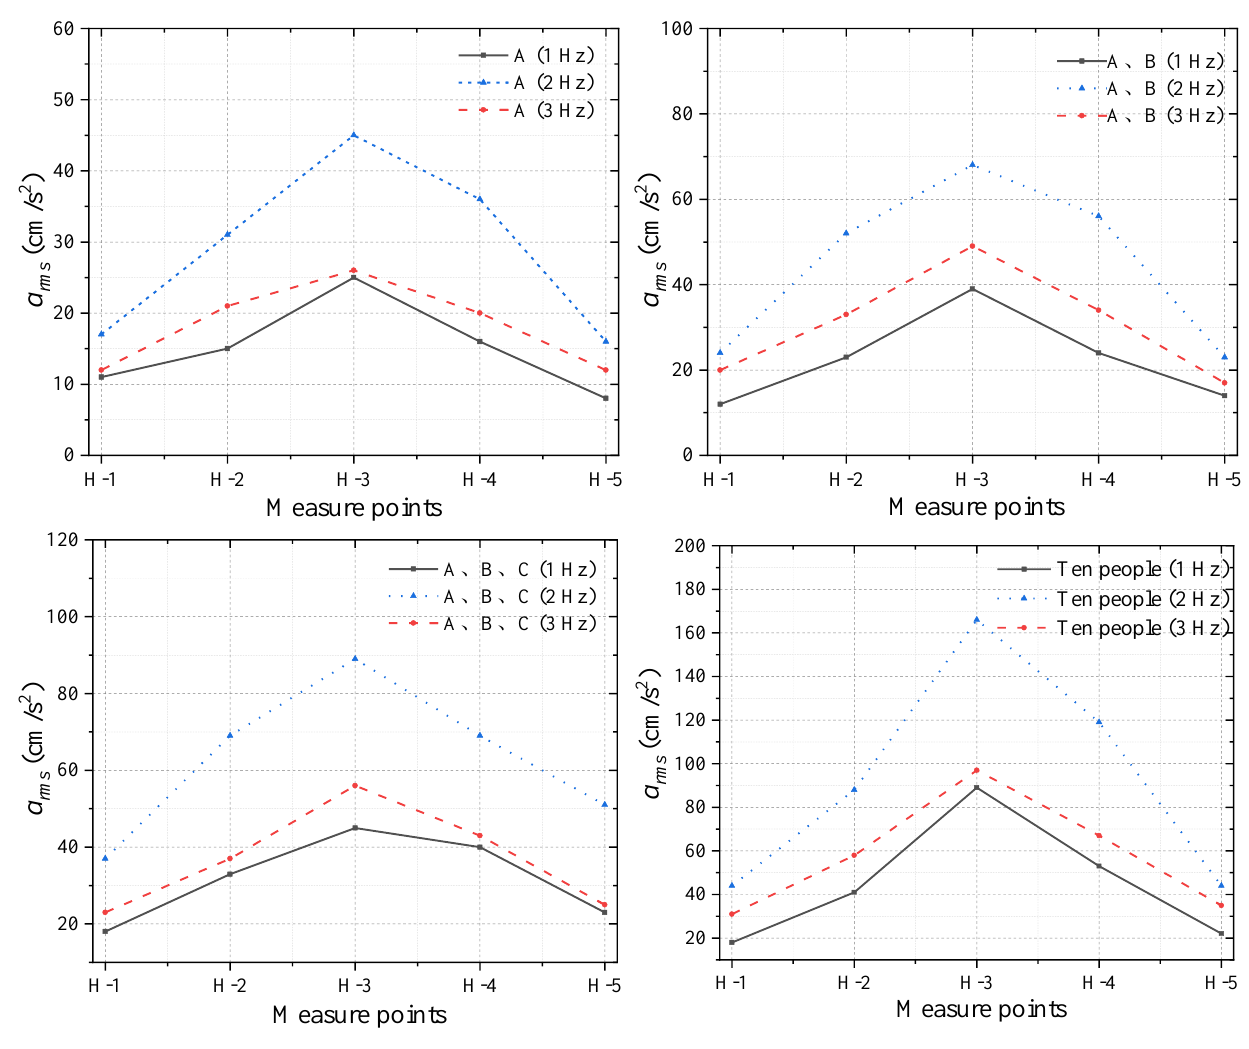
Figure 14. RMS max at different frequency.